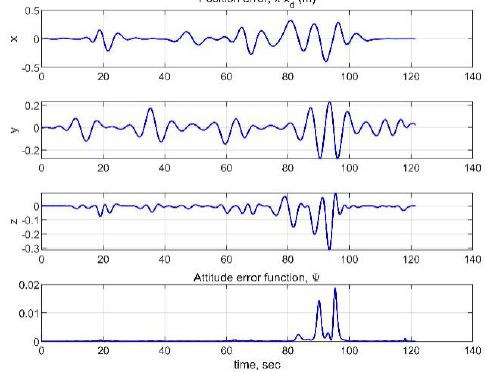
Figure 10. Error analysis between two trajectories.